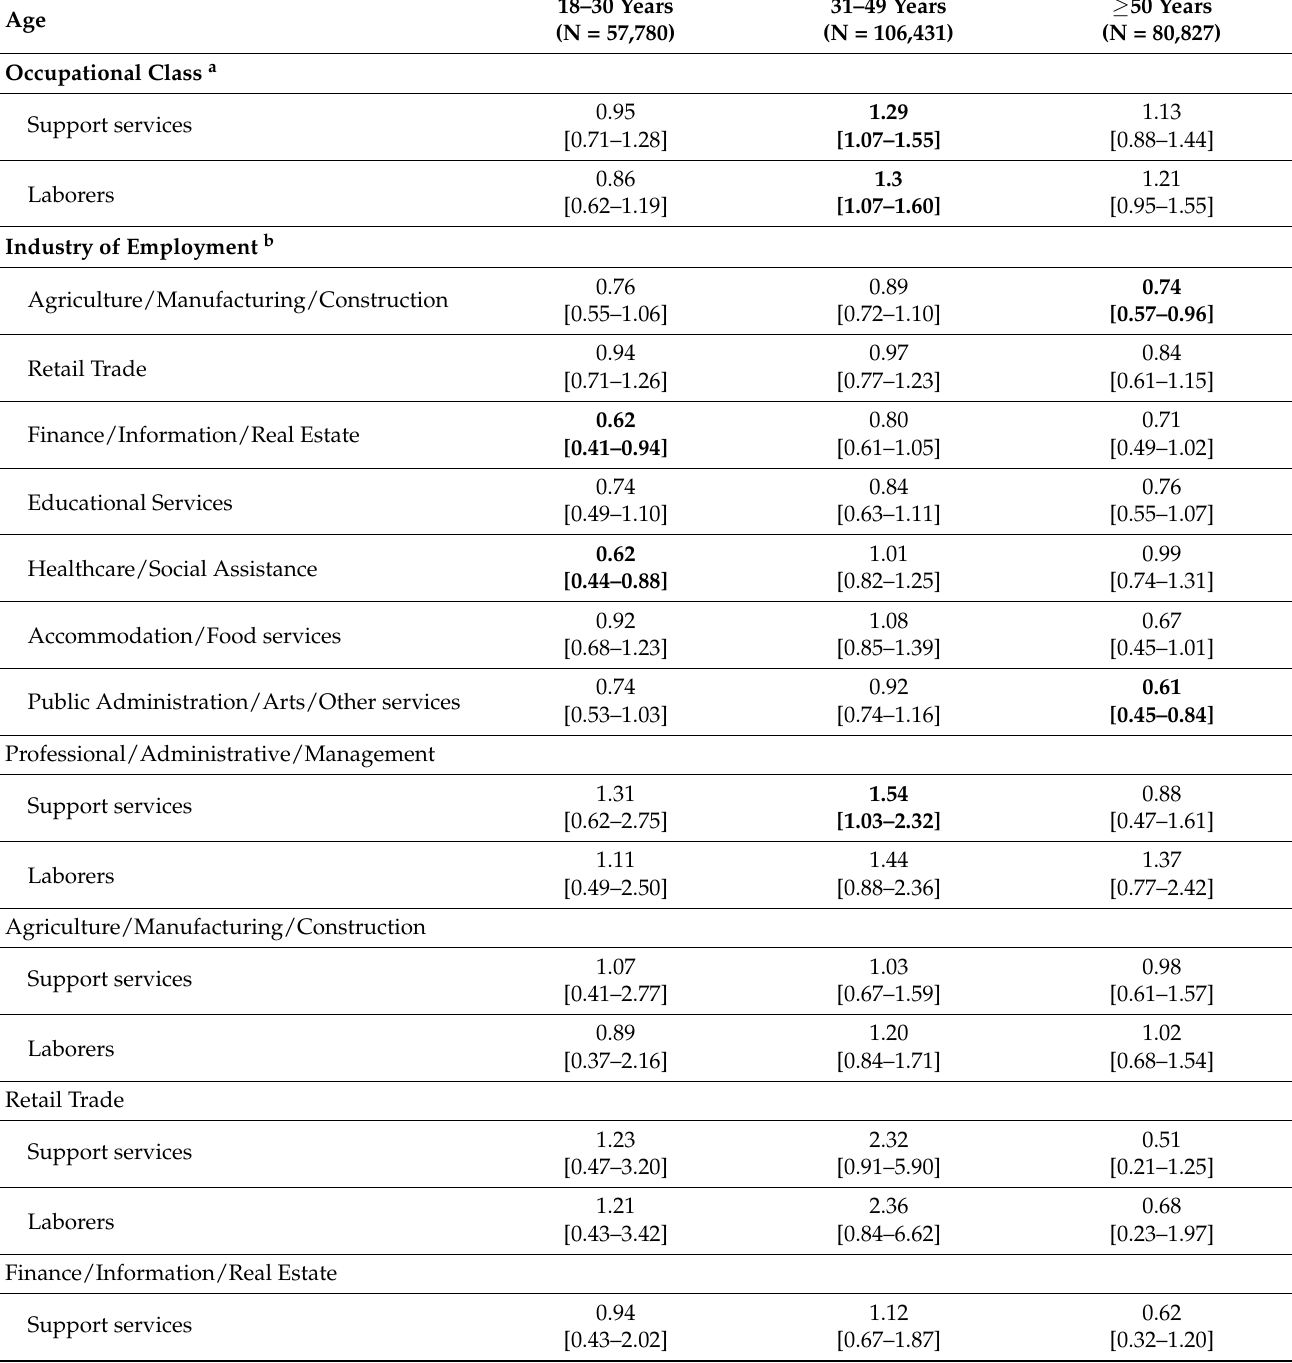
Table 4. Adjusted Prevalence Ratios (95% Confidence Intervals) for the Association Between Oc- cupational Class (compared to Professional/Management positions) and Industry of Employment (compared to the Professional/Administrative/Management Industry) and Serious Psychological Distress, Stratified by Age, National Health Interview Survey, 2004–2018, (N =